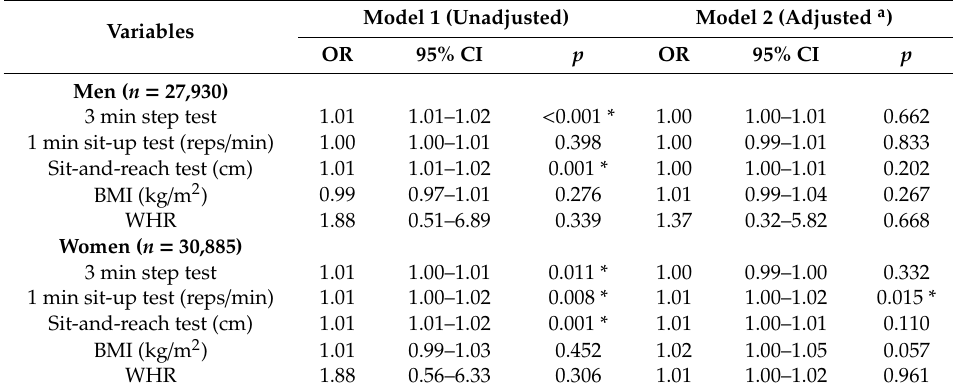
Table 3. Multivariate-adjusted ORs for happiness’ relation to health-related physical fitness measurements after adjustment for potential